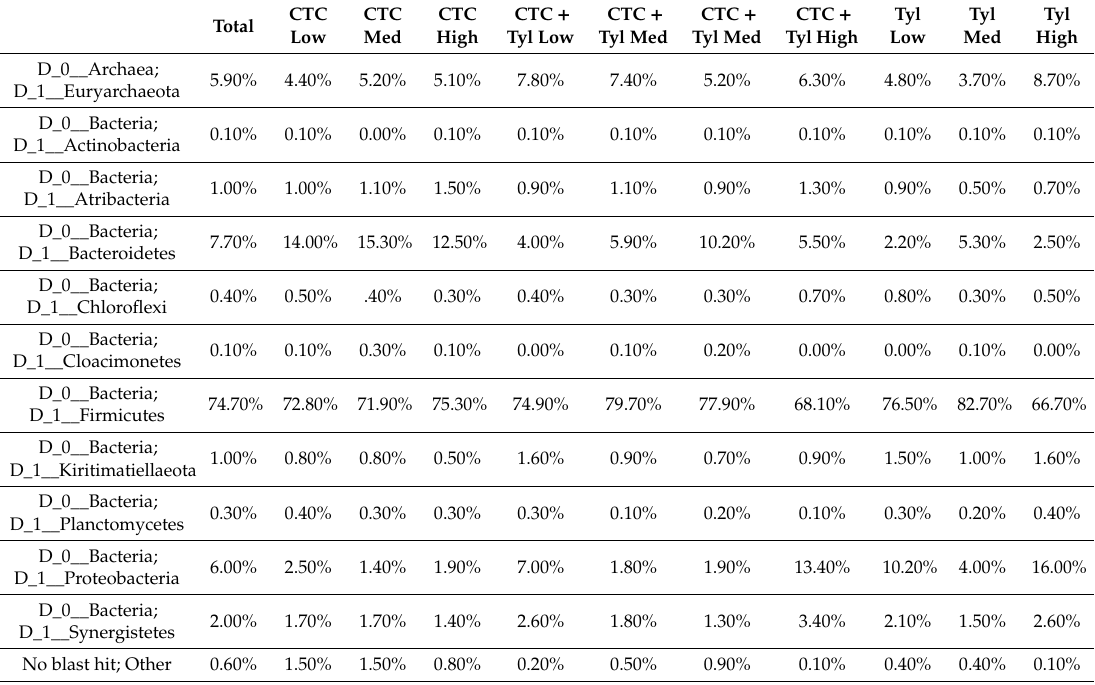
Table 11. Percentages of di ff erent microorganisms with various treatment